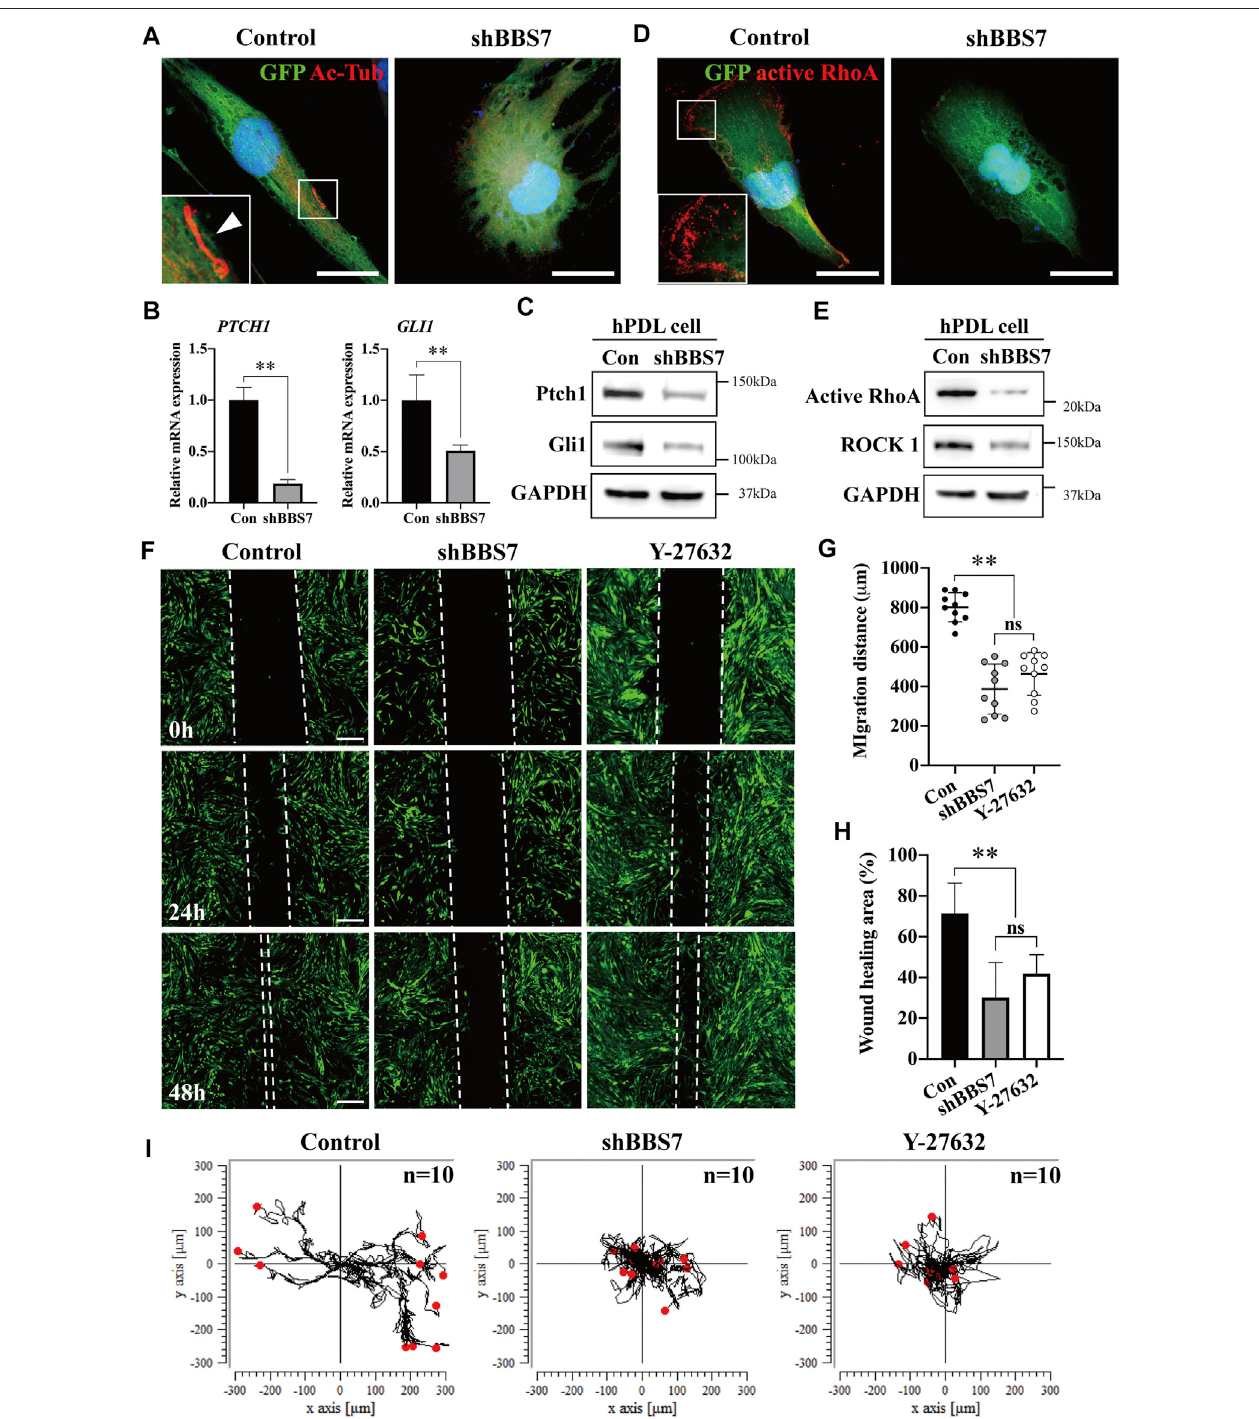
FIGURE3| Effectof BBS7 knockdown ontheprimary PDL cellmigration. (A) GFP-labeledPDL cellsarestainedwith Ac-Tub(red), and nucleiarestainedwithTO- PRO-3(blue).Theprimarycilia(arrowhead)wereobservedinthecontrolgroup.PDLcellswerespindle-shapedinthecontrolgroup,whereastheywereroundinshapein the shBBS7 group. (B) Relative mRNA expression of Shh signaling molecules. Compared to the control group, the expression of PTCH1 and GLI1 was signi fi cantly decreased in the shBBS7 group. (C) Immunoblotting with Ptch1, Gli1, and GAPDH antibodies. The Ptch1 and Gli1 protein expressions were signi fi cantly decreased in the shBBS7 group. (D) Actomyosin cytoskeleton – related kinase is stained with active RhoA (red), and nuclei are stained with TO-PTO-3 (blue). (E) Immunoblotting with active RhoA, ROCK1, and GAPDH antibodies. The active RhoA and ROCK1 protein expressions were signi fi cantly decreased in the